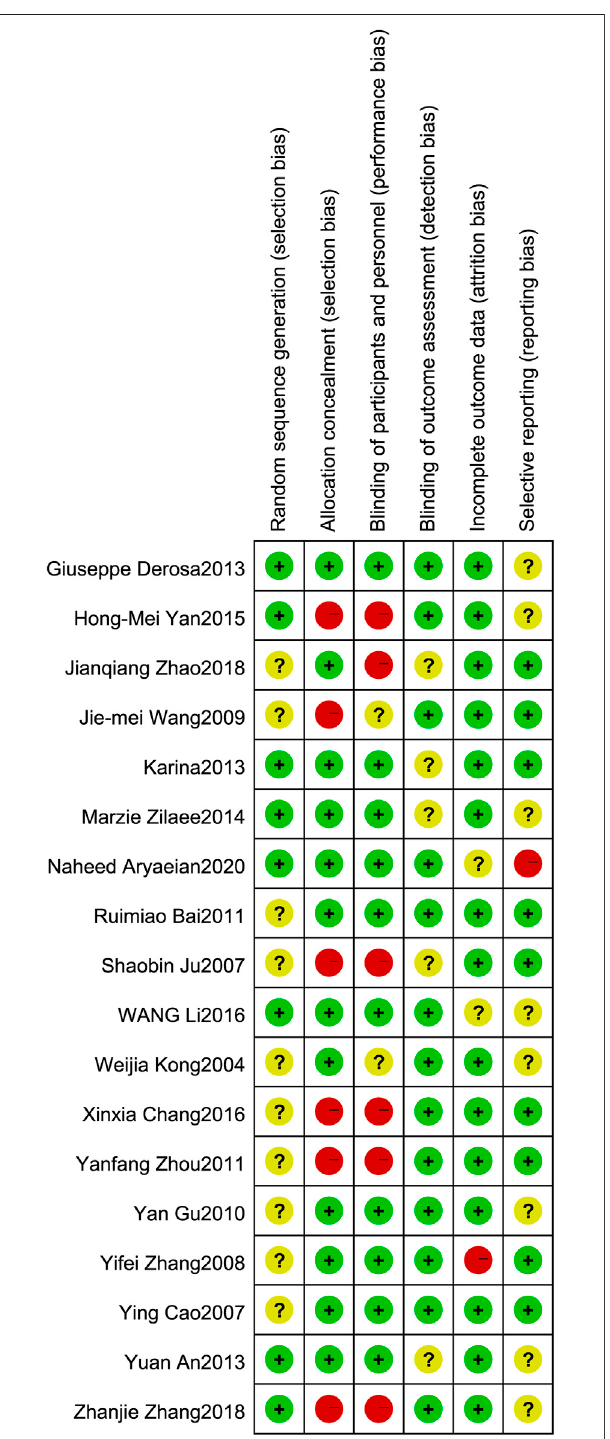
FIGURE 2 | that a double-blind study design is considered low risk. (4) Blinding of outcome assessment (detection bias): there is a return visit record or related explanation in the article that is considered low risk. (5) Incomplete outcome data (attrition bias): no outliers during the trial are considered low risk. (6) Selective reporting (reporting bias): no selective report treatment data are considered low